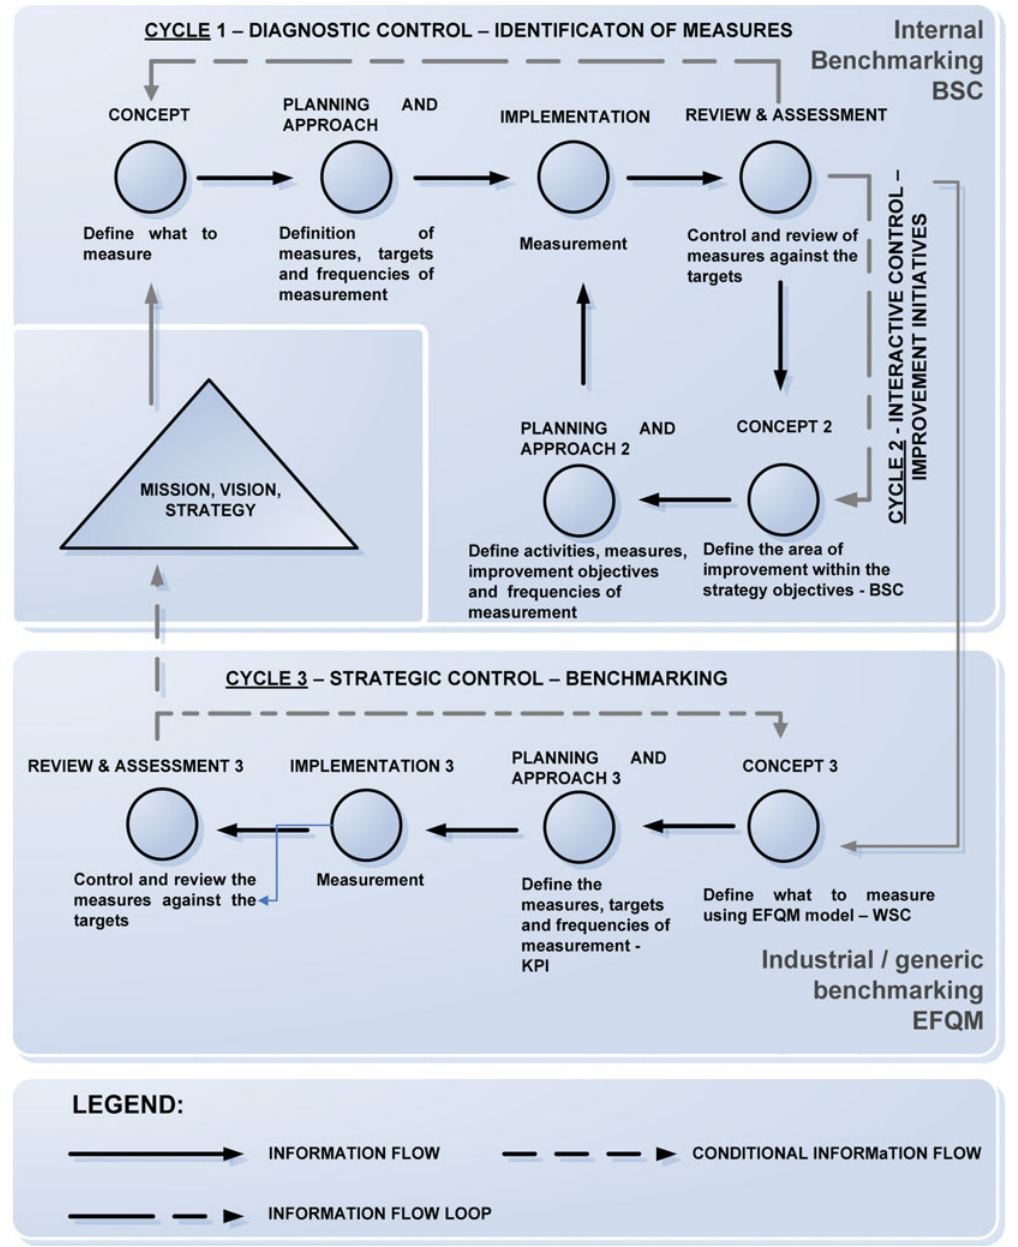
Fig. 5. The three cycles of the monitoring and control